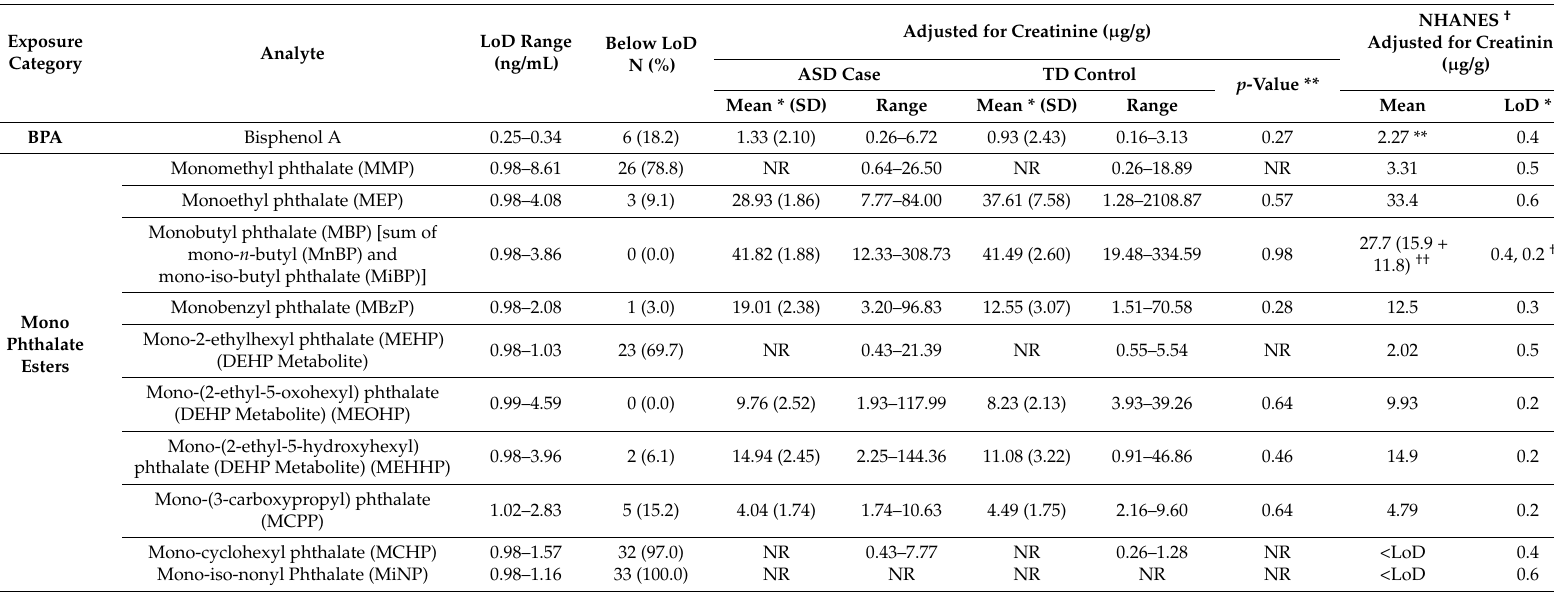
Table 3. Geometric mean and standard deviation (SD) of BPA and mono phthalate esters concentrations in urine adjusted for creatinine ( µ g/g) by ASD case status (based on 24 ASD cases and 8 TD controls) compared with concentrations reported by National Health and Nutrition Examination Survey